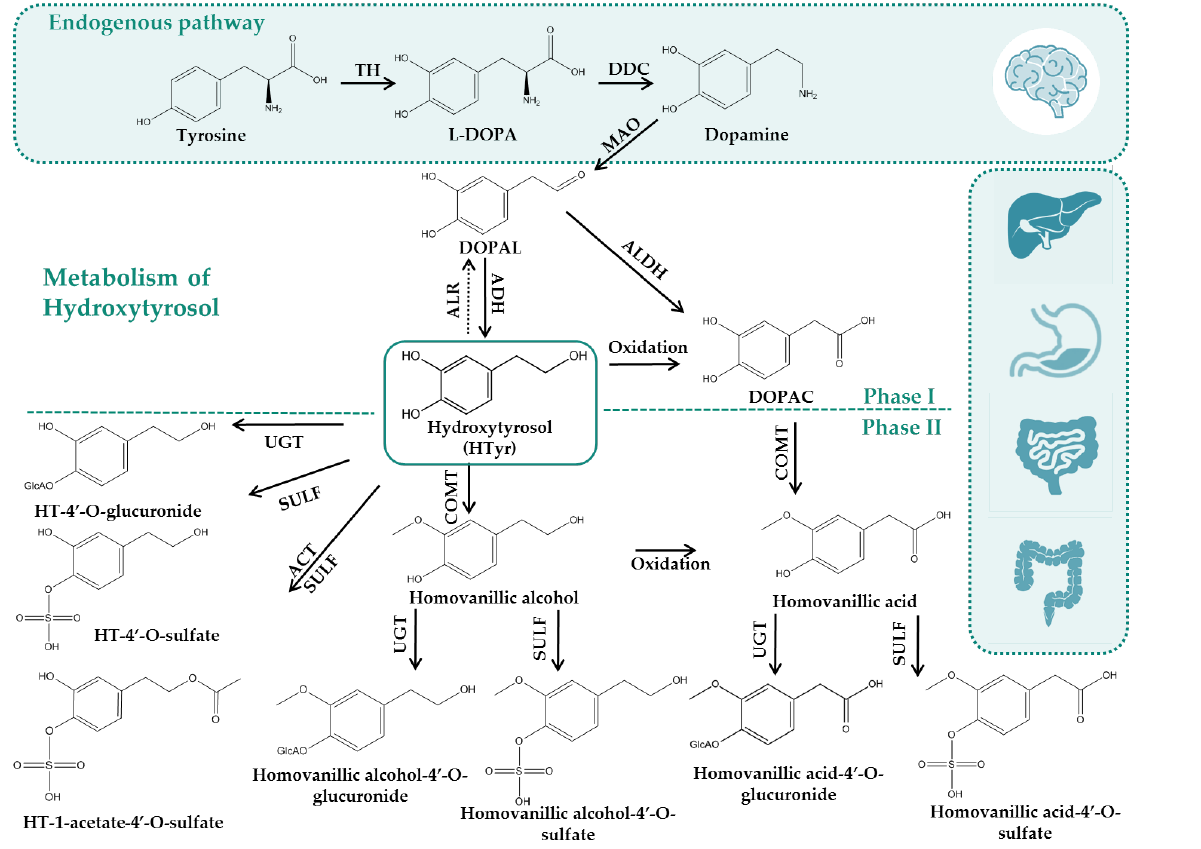
Figure 3. Biosynthesis and metabolism of hydroxytyrosol (HTyr) in in vivo systems. TH: tyrosine hydroxylase, DDC: dopa decarboxylase, MAO: monoaminoxidase, ALR: aldehyde reductase, ADH: alcohol dehydrogenase, ALDH: aldehyde dehydrogenase, COMT: catechol-O-methyl transferase, UGT: uridine 5′ -diphosphoglucuronosyl transferases, SULF: sulfotransferase, ACT: O- acetyltransferase.